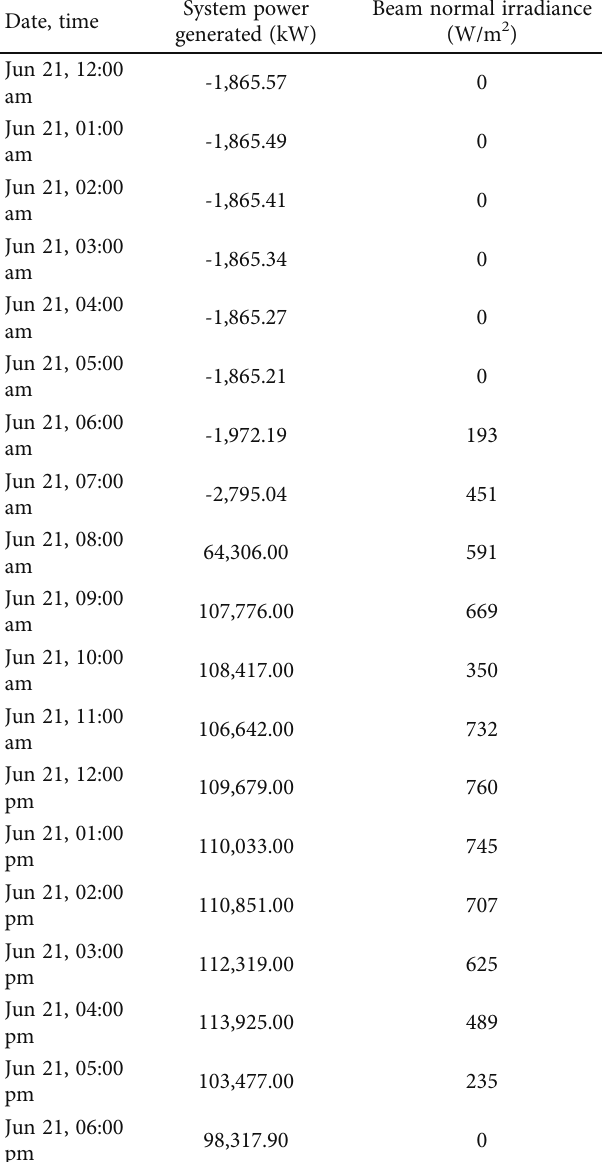
Table 5: Design point DNI